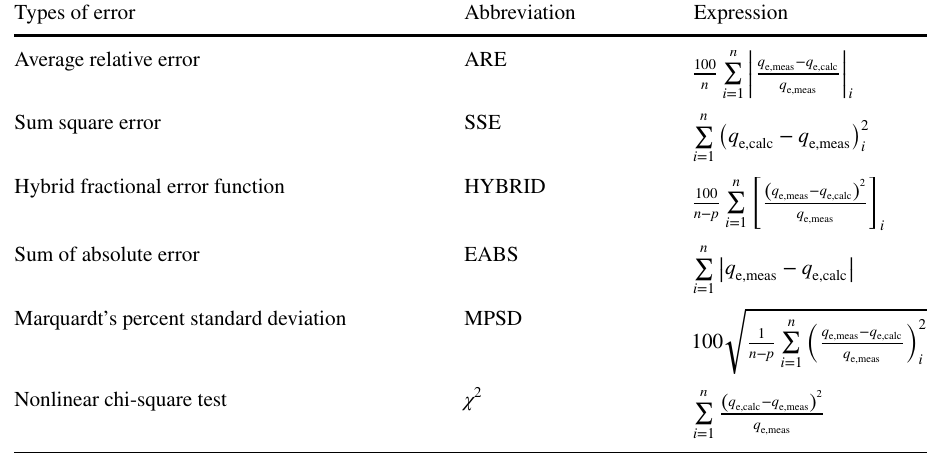
n is the number of experi-